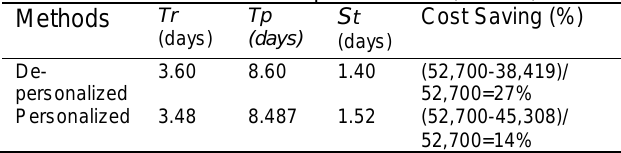
Table 1. Call volume in terms of the number of calls, and the root mean squared error